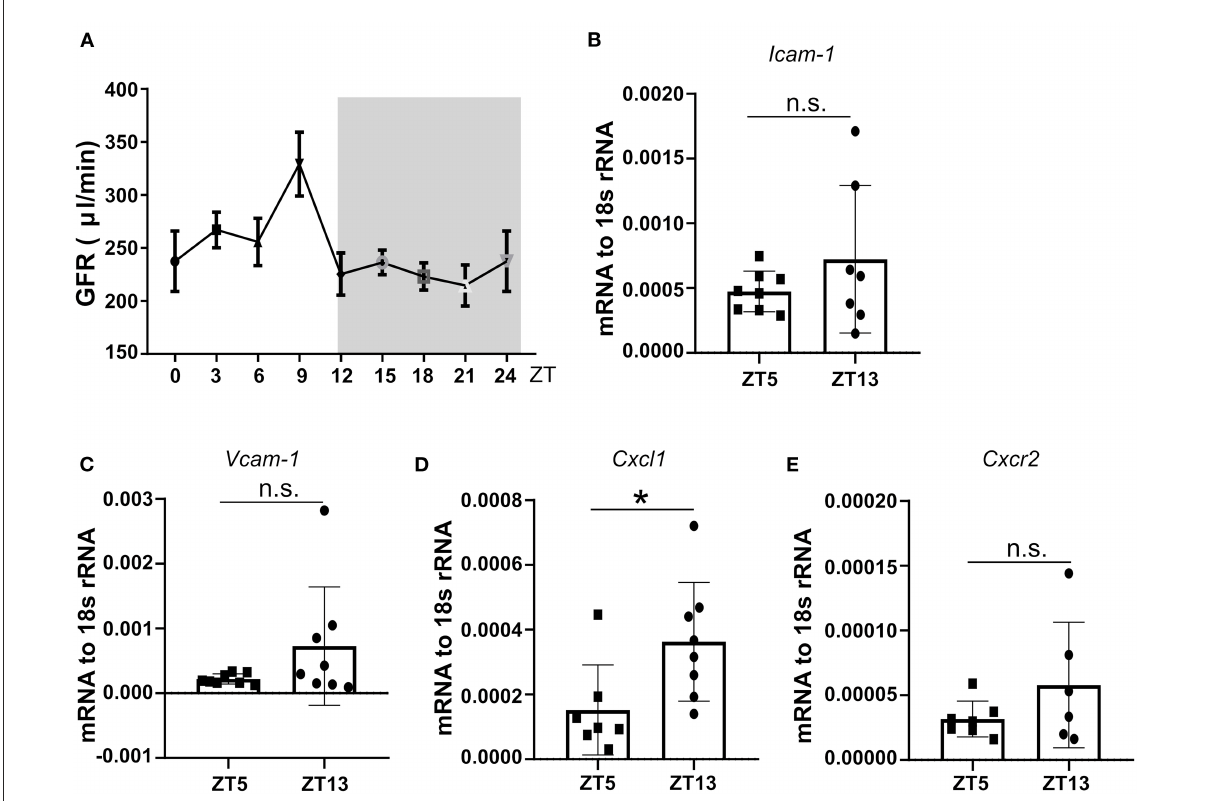
FIGURE3 The circadian oscillation of mouse GFR, kidney mRNA expression levels of adhesion molecules, and chemokines at ZT5 and ZT13 in a healthy state. (A) Circadian oscillations of mouse GFR in the healthy state ( n = 8–10 mice/group). (B,C) mRNA expression of adhesion molecule Icam-1 ( B , n = 7–8 mice/group) and Vcam-1 ( C , n = 7–8 mice/group) in mice kidney at ZT5 and ZT13. (D) mRNA expression of neutrophil mediating chemotaxis Cxcl1 ( D , n = 7–8 mice/group) and its receptor Cxcr2 ( E , n = 6–7 mice/group) at ZT5 and ZT13. Icam-1 , intercellular adhesion molecule 1; Vcam-1 , vascular cell adhesion molecule 1; Cxcr2 , CXC chemokine receptor 2; Cxcl1 , CXC motif chemokine ligand 1. While background: daytime, gray background: nighttime. Data are means ± SD , unpaired Student’s t -test, * P <